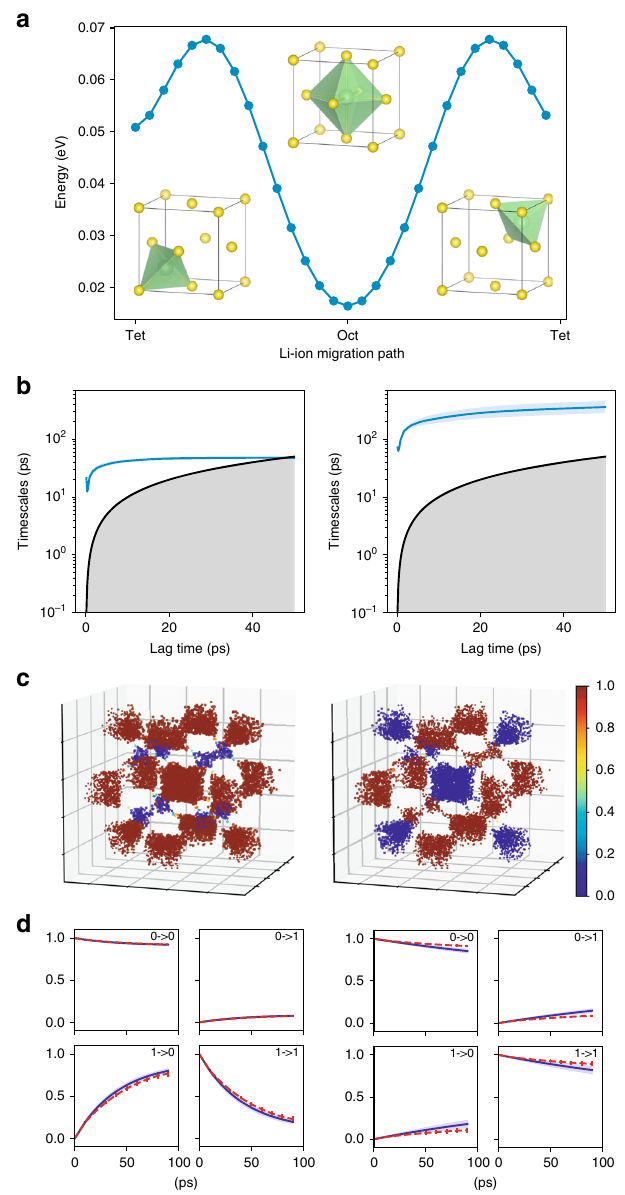
Fig. 2 A two-state dynamic model learned for a lithium ion in the face- centered cubic lattice. a Structure of the FCC lattice and the relative energies of the tetrahedral and octahedral sites. b – d Comparison between the local dynamics (left) learned with GDyNet and the global dynamics (right) learned with a standard VAMPnet. b Relaxation timescales computed from the Koopman models as a function of the lag time. The black lines are reference lines where the relaxation timescale equals to the lag time. c Assignment of the two states in the FCC lattice. The color denotes the probability of being in state 0, which corresponds to one of the two states that has a larger population. d CK test comparing the long- time dynamics predicted by Koopman models at τ = 10 ps (blue) and actual dynamics (red). The shaded areas and error bars in b , d report the 95% con fi dence interval from fi ve independent trajectories by dividing the test data equally into